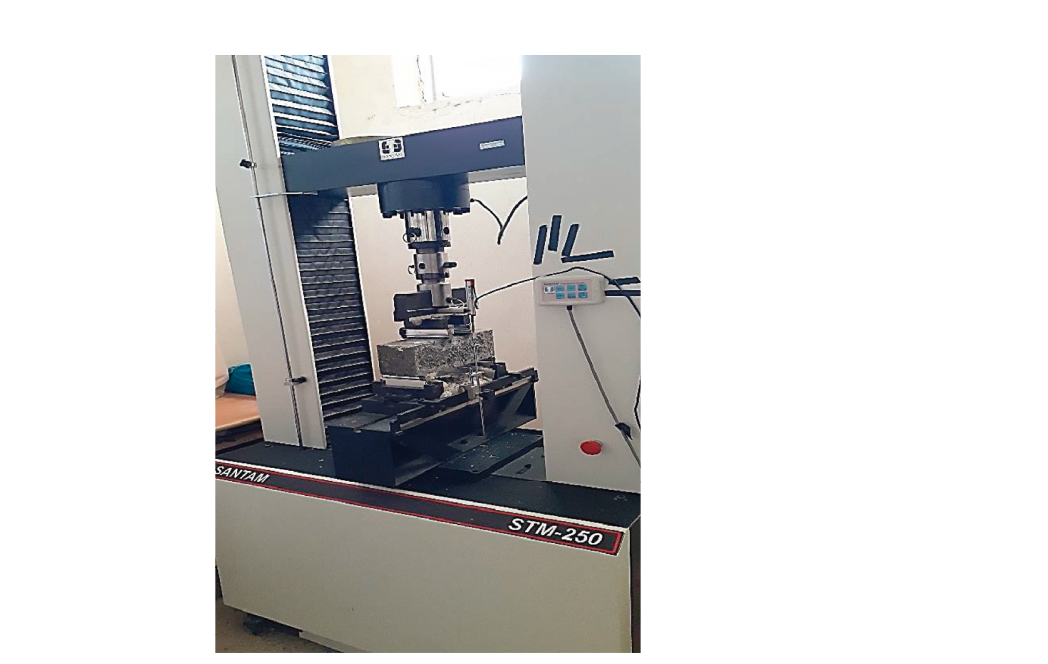
Figure 5: Test apparatus for determining the flexural